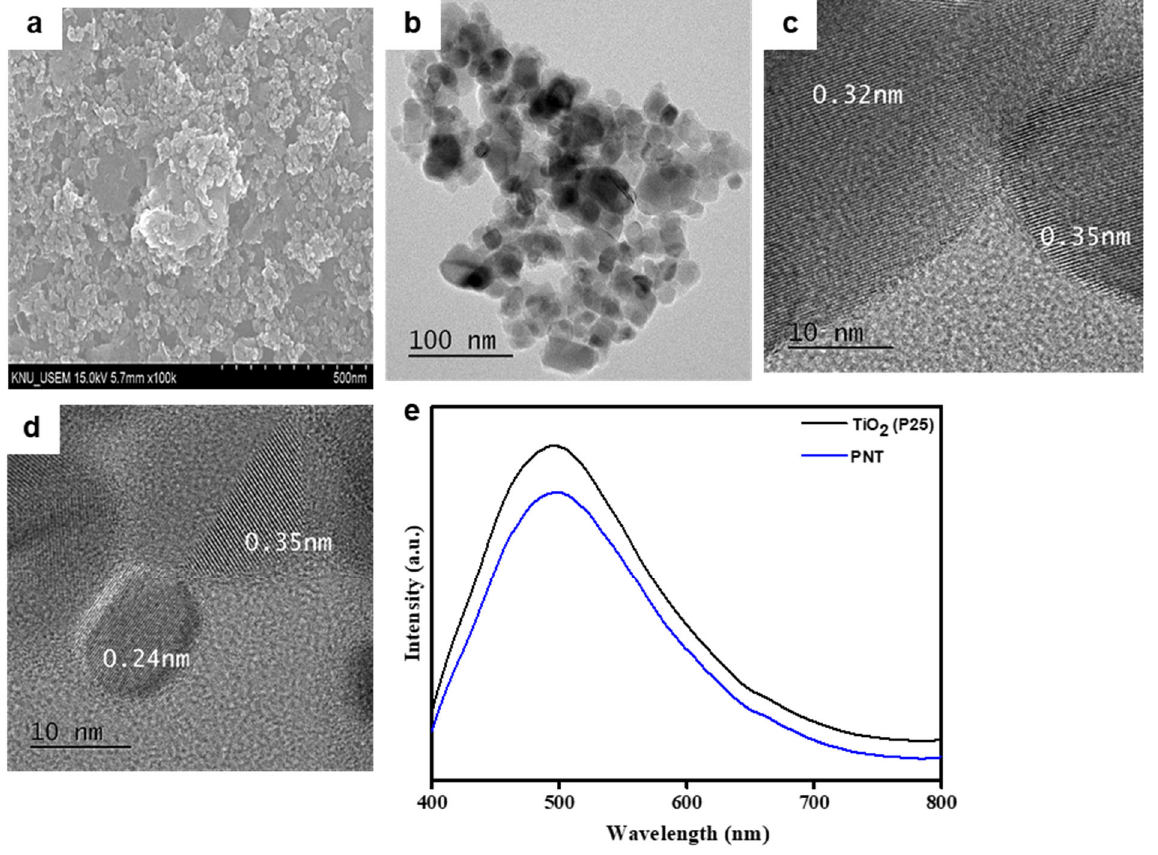
Figure 2. ( a ) SEM image of PNT on glass substrate, ( b ) HRTEM image of PNT, ( c , d ) lattice image of PNT, ( e ) photoluminescence spectra of